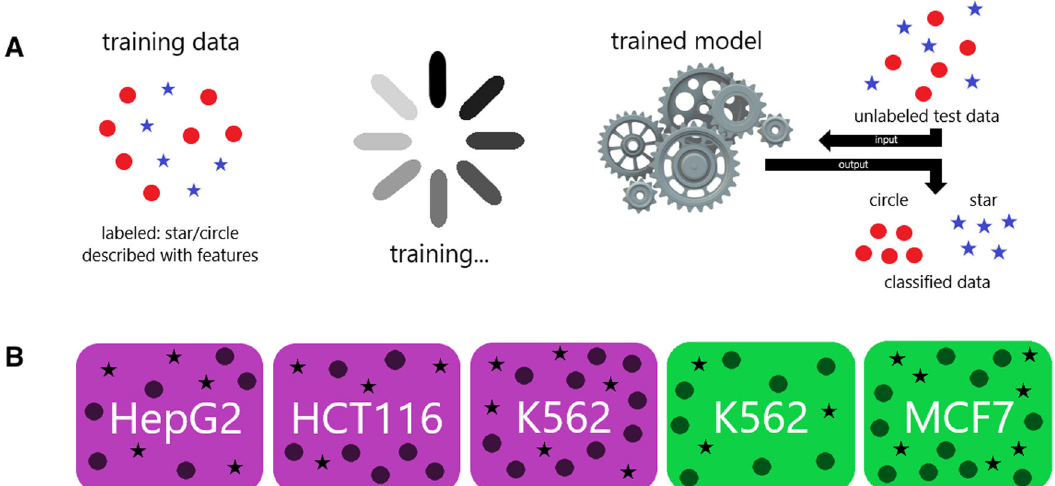
Fig. 1 Schematic of training and testing the models. The pipeline illustrated here is for the classi fi cation of enhancer-gene pairs into active vs. inactive. The training data consists of examples of active enhancer-gene pairs (links) and inactive enhancer-gene pairs represented by stars and circles. Panel A shows the training data as labeled (i.e., the model is able to see which enhancer-gene pair belongs to the active and inactive class) and described features believed to be predictive of activity status. In the training phase, a machine learning algorithm learns which patterns in the feature data best differentiates the two classes and builds a predictive model. The trained model is then able to take new, unlabeled data as input and output a classi fi cation score based on what it learned in the training phase. Test data not used in the training phase is used to unbiasedly measure the prediction performance of the trained model, where the class of each observation is known to the user but unknown to the classi fi er. In this way, it is possible to determine how well the model classi fi es new data. B In this analysis, there were three training datasets (purple) from three different cell lines. There are also two test datasets which were never used for model training (green), which come from two cell types. If a training dataset is not used for training the model, it may also serve as a testing dataset for a model using a different dataset to train on. For example, a model which uses HepG2 training data to train on may use any of the other datasets for testing. The same observations are never used for both training and testing a